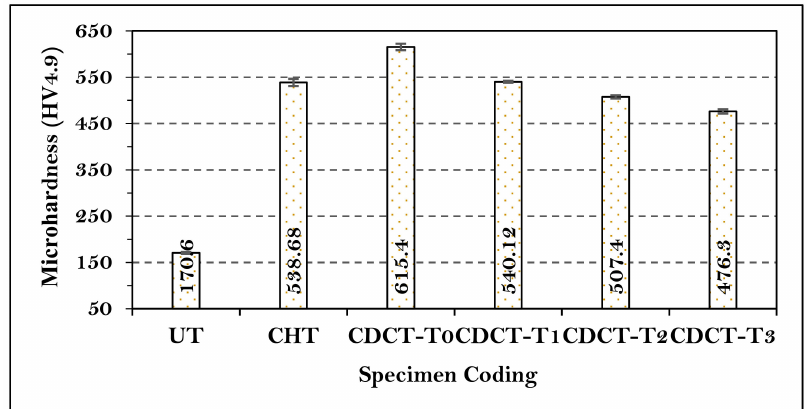
Figure 7. Microhardness of untreated and treated